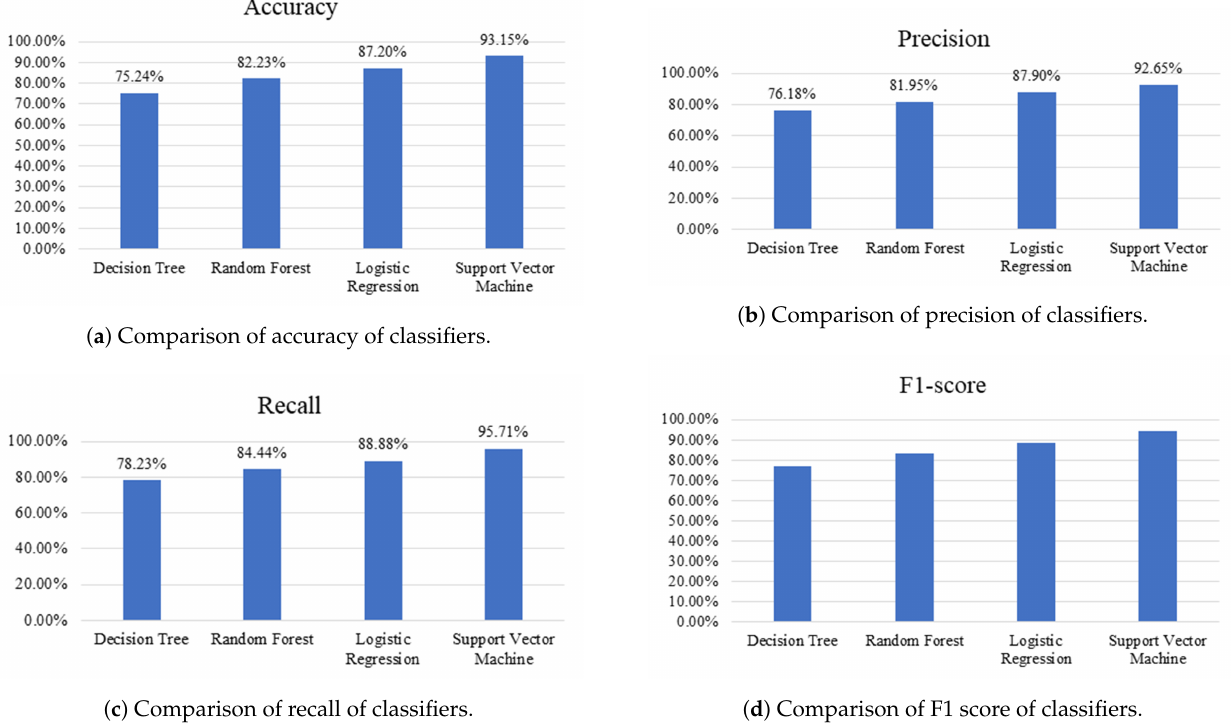
Figure 11. Accuracy, precision, recall, and F1-score of various